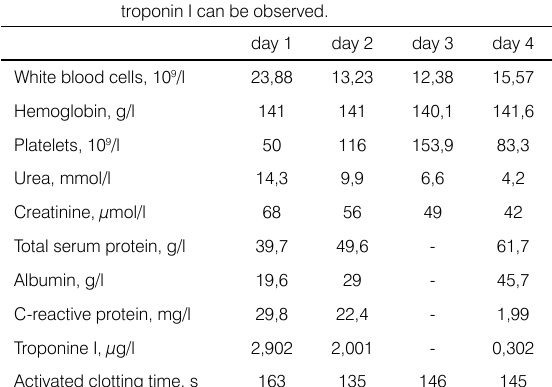
Table 2. The laboratory parameters during PediVas support. Gradually improvement of the white blood cells, urea, creatine, protein, albumin, C-reactive protein and troponin I can be